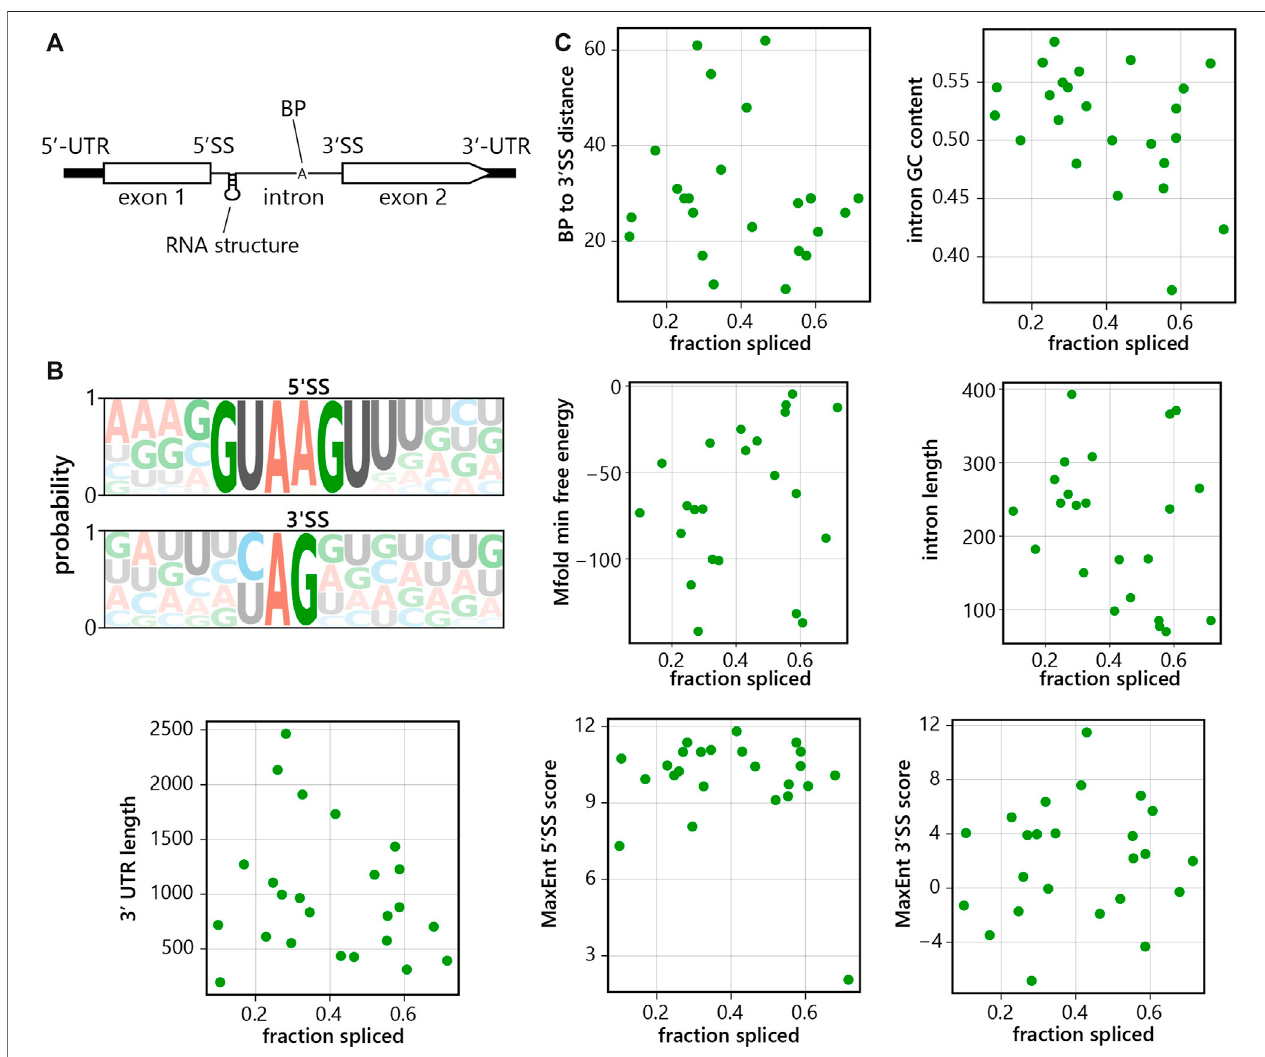
FIGURE5 | C. merolae intron features do notreliablypredict splicing ef fi ciency. (A) Scheme ofintron-containinggene,UTR (cid:1) untranslated region, SS (cid:1) splice site, BP (cid:1) branch point. (B) 5 ′ splice site (5 ′ SS) and 3 ′ splice site (3 ′ SS) consensus sequences of C. merolae introns. (C) Intrinsic features of each intron in C. merolae were analyzed to determine their correlation with splicing ef fi ciency (as calculated above, Figure 1B ). Each point represents a single intron. Features analyzed included: branchpoint to 3 ′ SS distance (Pearson ’ s correlation ( r ) (cid:1) − 0.148, p (cid:1) 0.489), 3 ′ SS score ( r (cid:1) 0.118, p (cid:1) 0.582), 5 ′ SS score ( r (cid:1) -0.237, p (cid:1) 0.264), GC content ( r (cid:1) − 0.413, p (cid:1) 0.045), predicted secondary structure ( r (cid:1) 0.408, p (cid:1) 0.048), intron length ( r (cid:1) -0.421, p (cid:1) 0.040), and gene 3 ′ UTR length ( r (cid:1) − 0.191, p (cid:1)